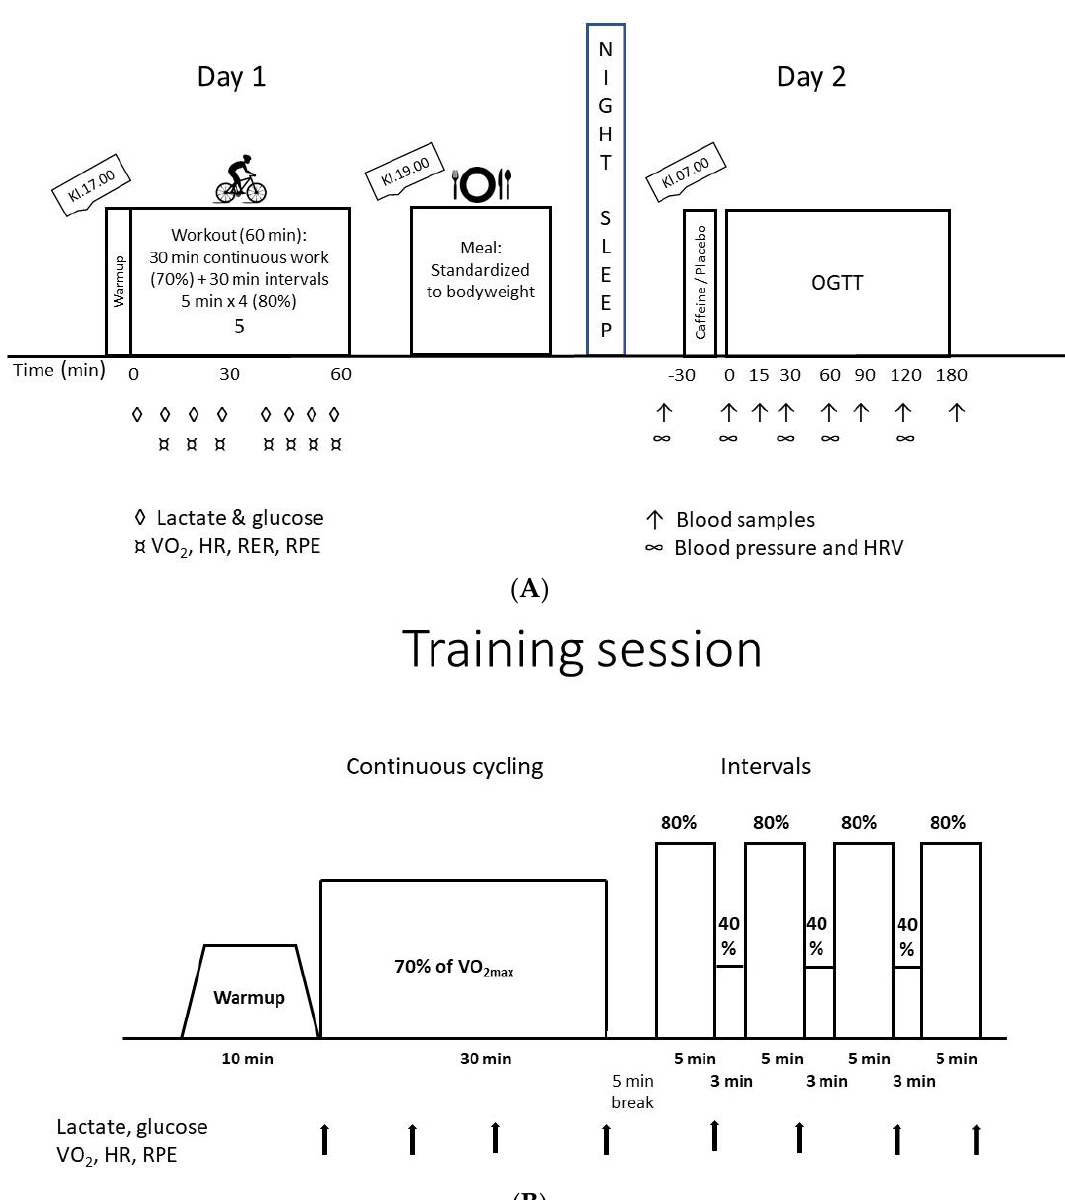
Figure 1. Schematic overview of the design study. ( A ) Schematic overview of the two intervention days completed four times. ( B ) Schematic overview of the acute bout of exercise completed the evening before the OGTT. Abbreviations to ( A ): OGTT: oral glucose tolerance test; VO 2 : oxygen uptake; HR: heart rate; RER; respiratory exchange ratio; RPE: rate of perceived exertion. Abbrevia- tions to ( B ): VO 2max : maximal oxygen uptake; VO 2 : oxygen uptake; HR: heart rate; RPE: rate of per- ceived exertion.